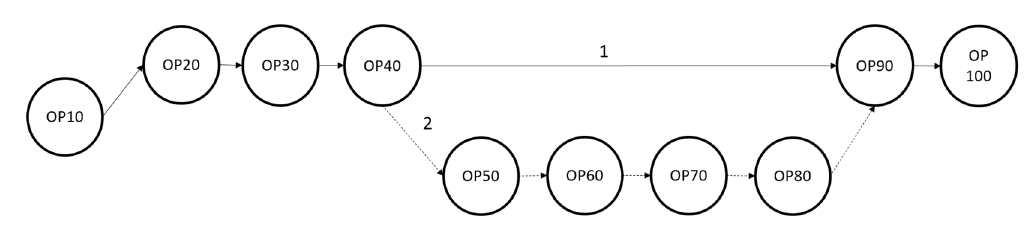
Figure 3. Precedence graph for operations of Table 2.